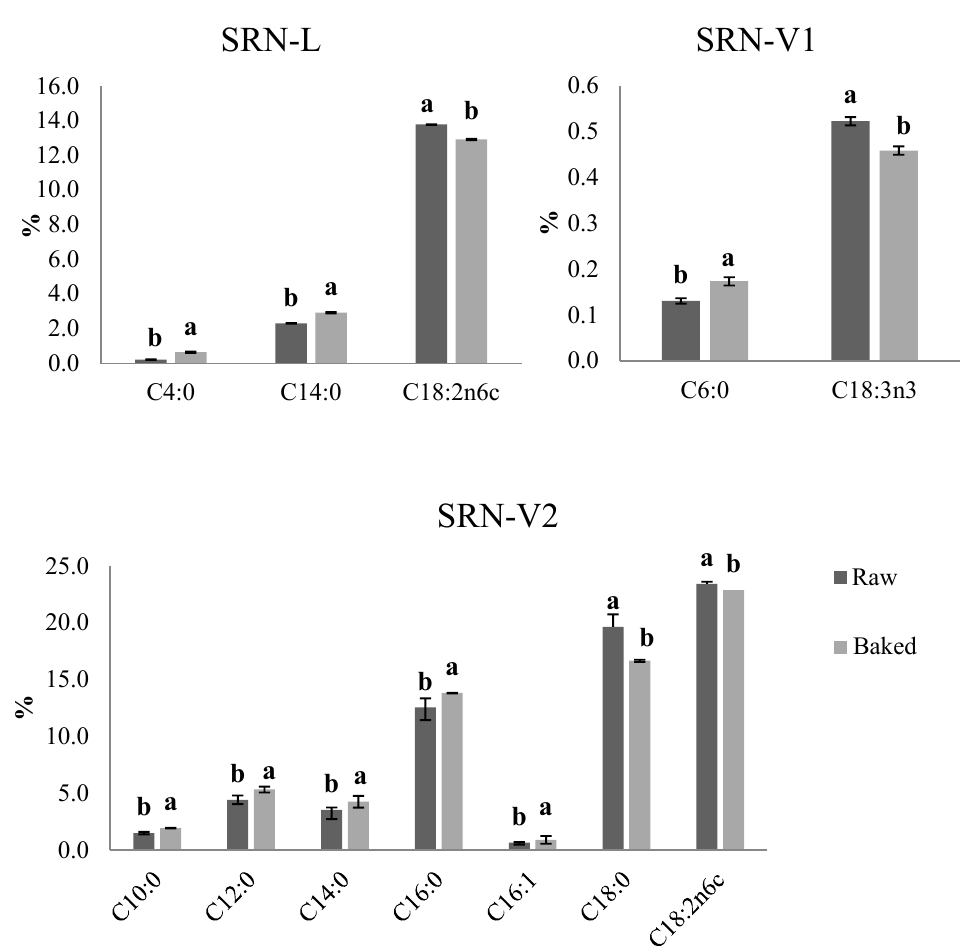
Figure 5. Changes in the fatty acid content of the raw and baked SRNs prepared with the different fat blends, L, V1, and V2. a,b: Different letters correspond to statistically significant differences ( p ≤ 0.05) for each parameter.